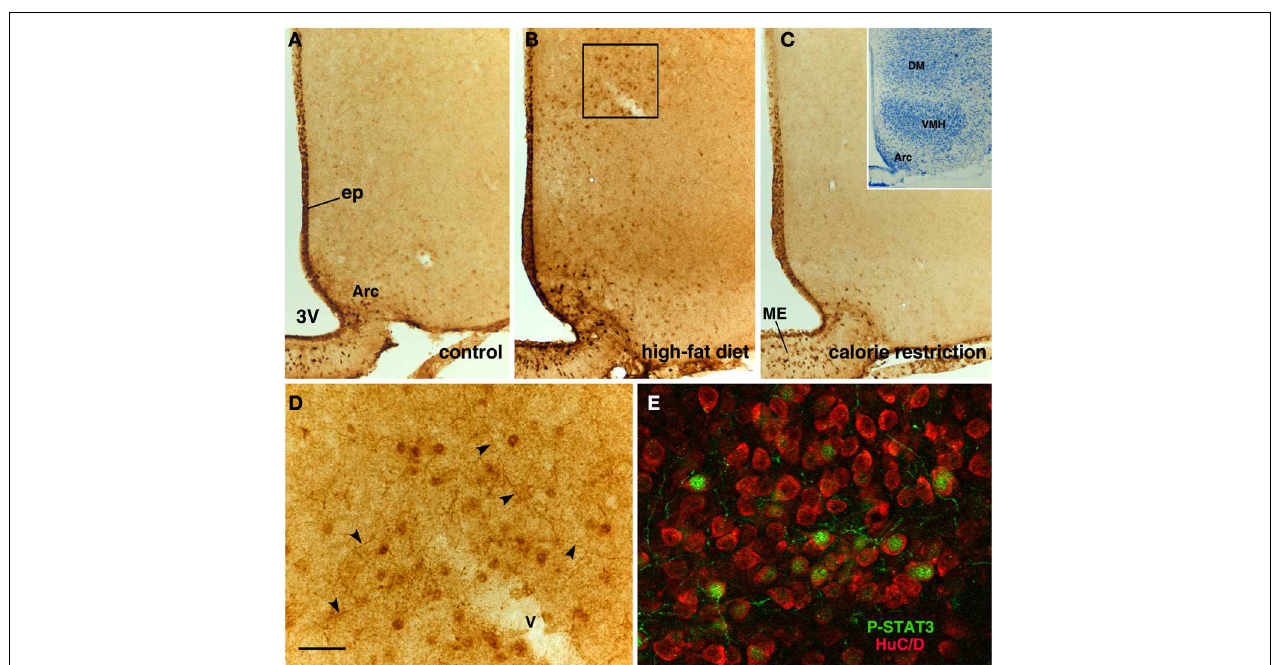
FIGURE 6 | P-STAT3 immunohistochemistry in the tuberal region of CNTF-treated mice. In a control mouse (A) , P-STAT3 staining depicts ependymal cells (ep) and neurons located in the arcuate nucleus (Arc) and median eminence (ME). In an HFD mouse (B) , P-STAT3 immunoreactivity increases at these sites, but responsiveness to CNTF is also detectable in the dorsomedial hypothalamus (DM) and, to a lesser extent, the ventromedial nucleus (VMH). CNTF responsiveness is blunted in a CR mouse (C) . The inset of (C) shows a representative